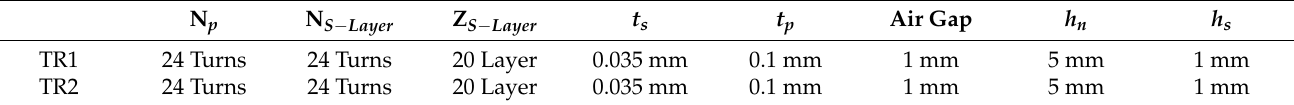
Table 2. Capacitance calculations and measurements for TR1 and TR2.